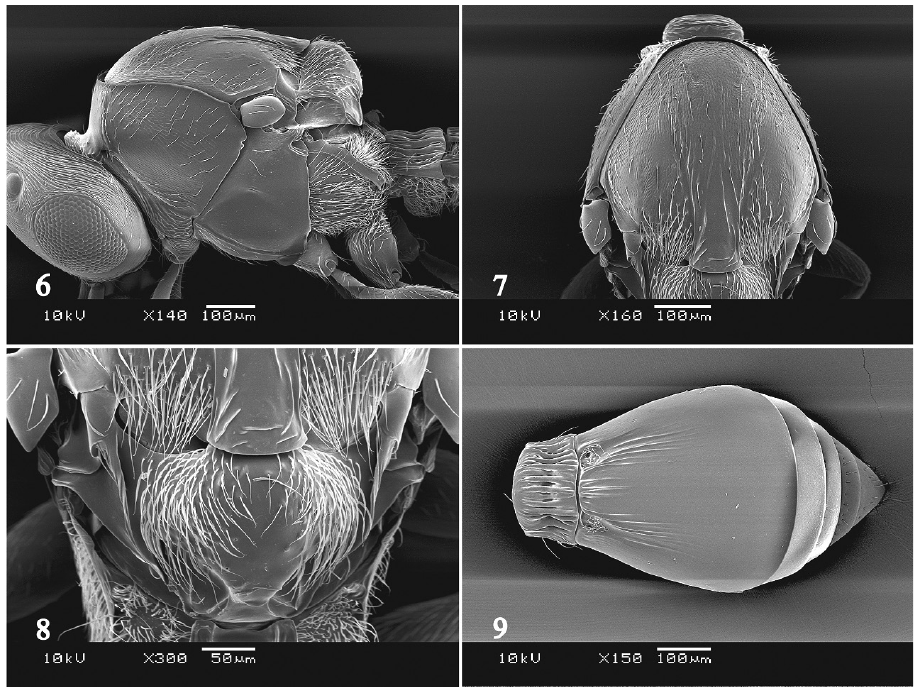
Figure 6–9. Platygaster ingeniosus . 6 female mesosoma, lateral view 7 female mesoscutum, dorsal view 8 female mesoscutellum, dorsal view 9 female metasoma, dorsal